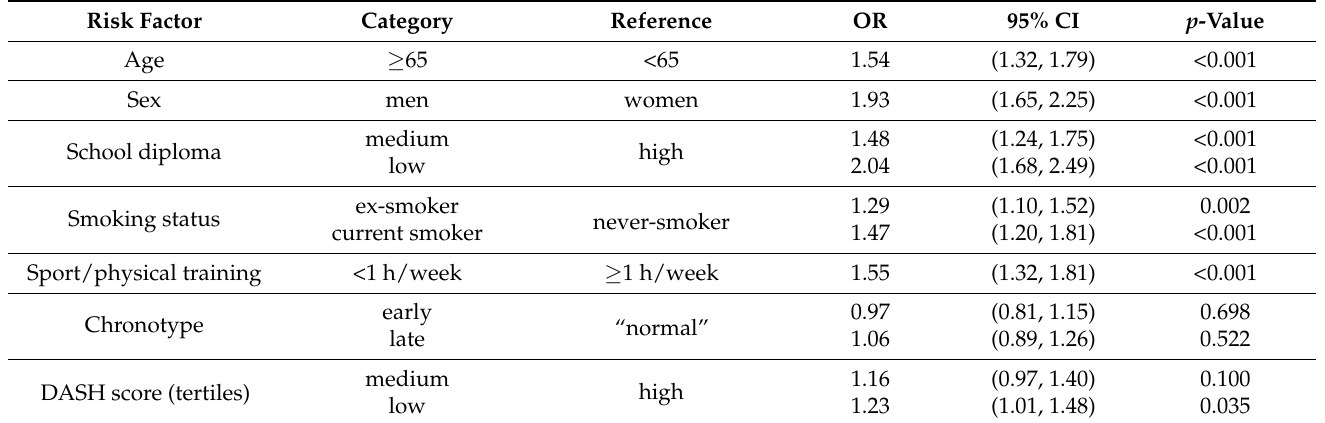
Table 5. Multiple logistic regression. Adjusted odds ratio (OR) estimates of pre-selected independent variables to the dependent variable metabolic syndrome ( n = 3513).